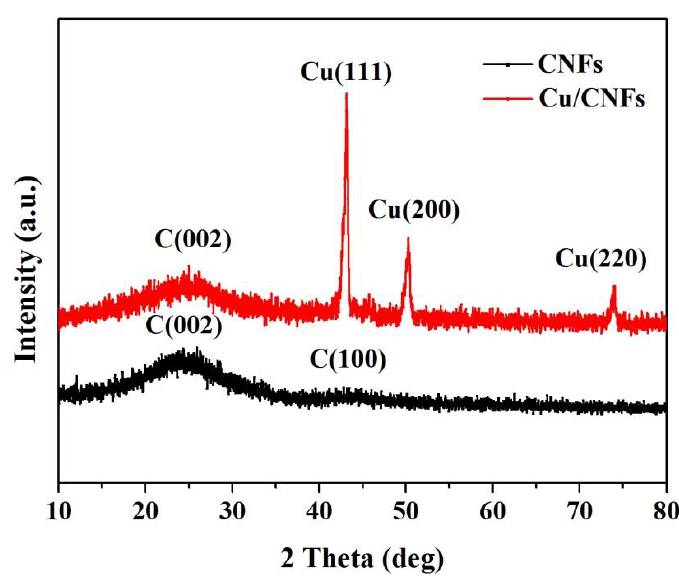
Figure 2. XRD patterns of CNFs and Cu/CNFs.